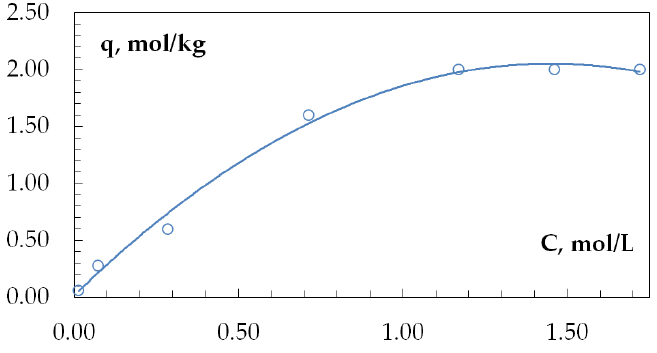
Figure 12. Results of acetone sorption by organic material.